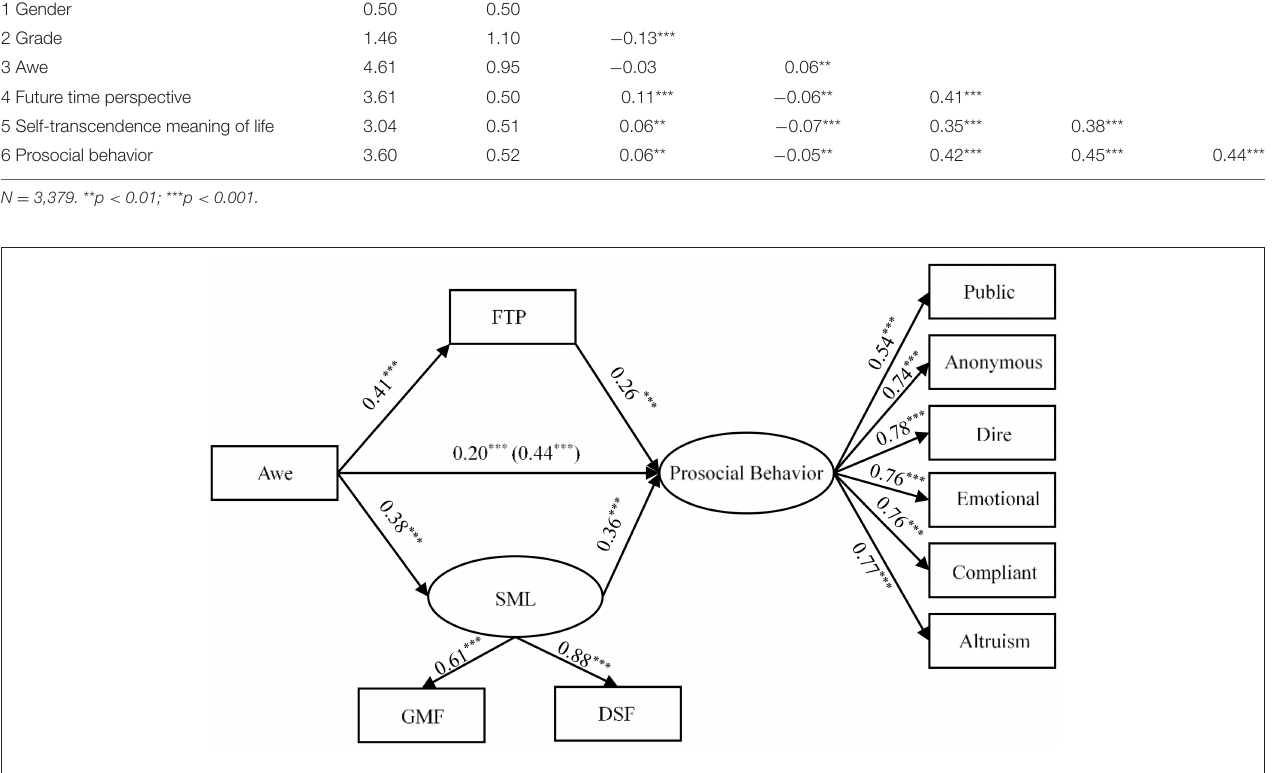
FIGURE 2 | The indirect effect of FTP and SML in the relationship between Awe and Prosocial Behavior. Standardized coefficients are reported; *** p < 0.001; FTP, future time perspective; SML, Self-transcendence Meaning of Life; GMF, Got the Meaning of the Failure; DSF, Detached from Success or